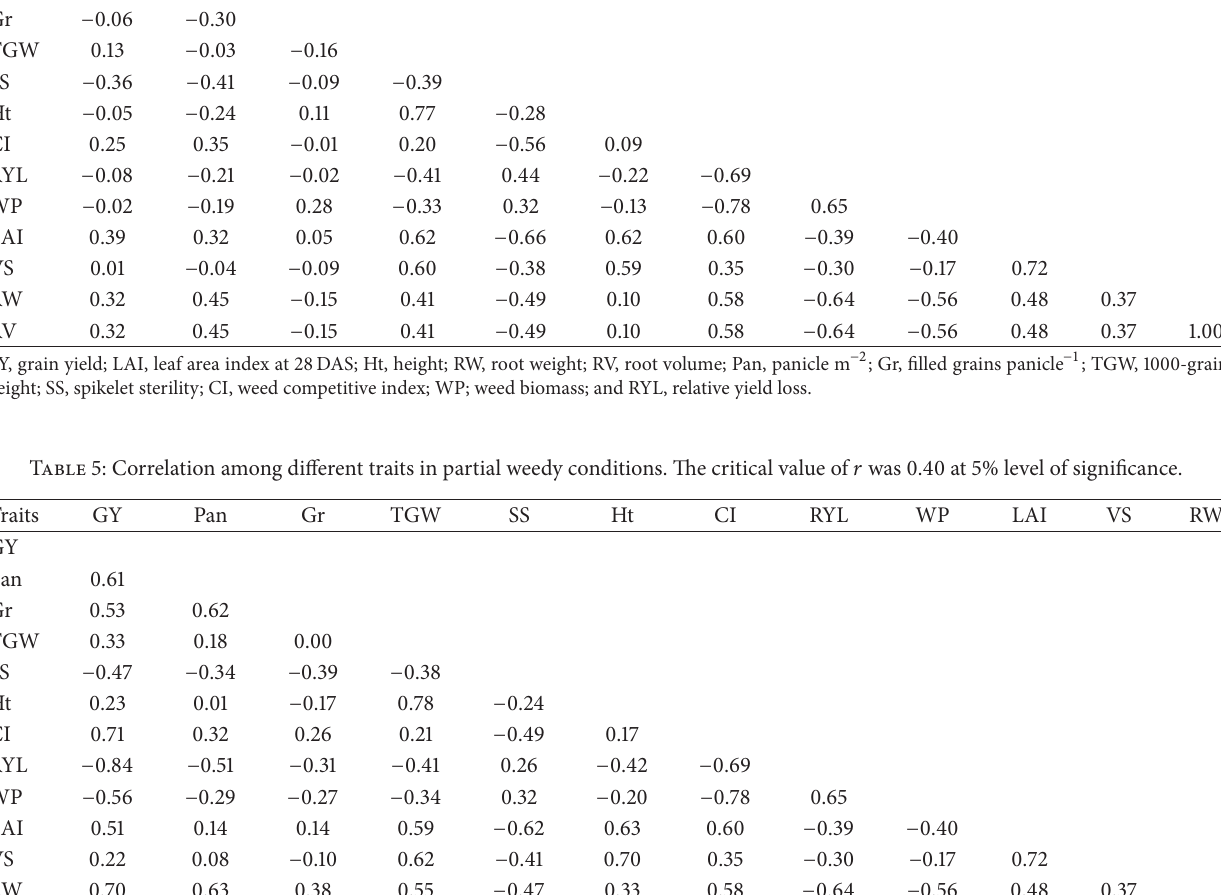
Table 4: Correlation among different traits in weed-free conditions. The critical value of 𝑟 was 0.40 at 5% level of significance. Traits GY Pan Gr TGW Pan − 0.16 SS − 0.36 − 0.41 Ht − 0.05